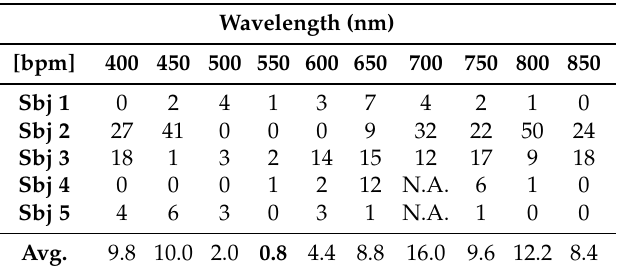
Table 2. Errors calculated as absolute differences between heart rate obtained from the electrocardiogram (ECG) track and SPAD pulse signals. Bold values represent best results.